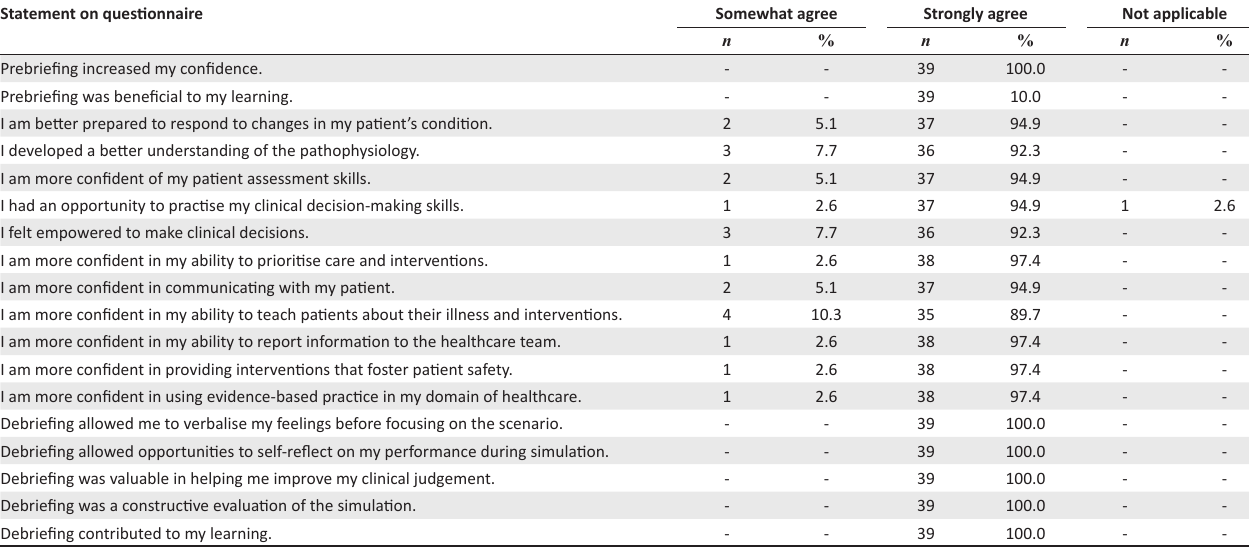
TABLE 2: Students’ feedback as per the Simulation Effectiveness Tool – Modified questionnaire ( n = 39). Statement on questionnaire